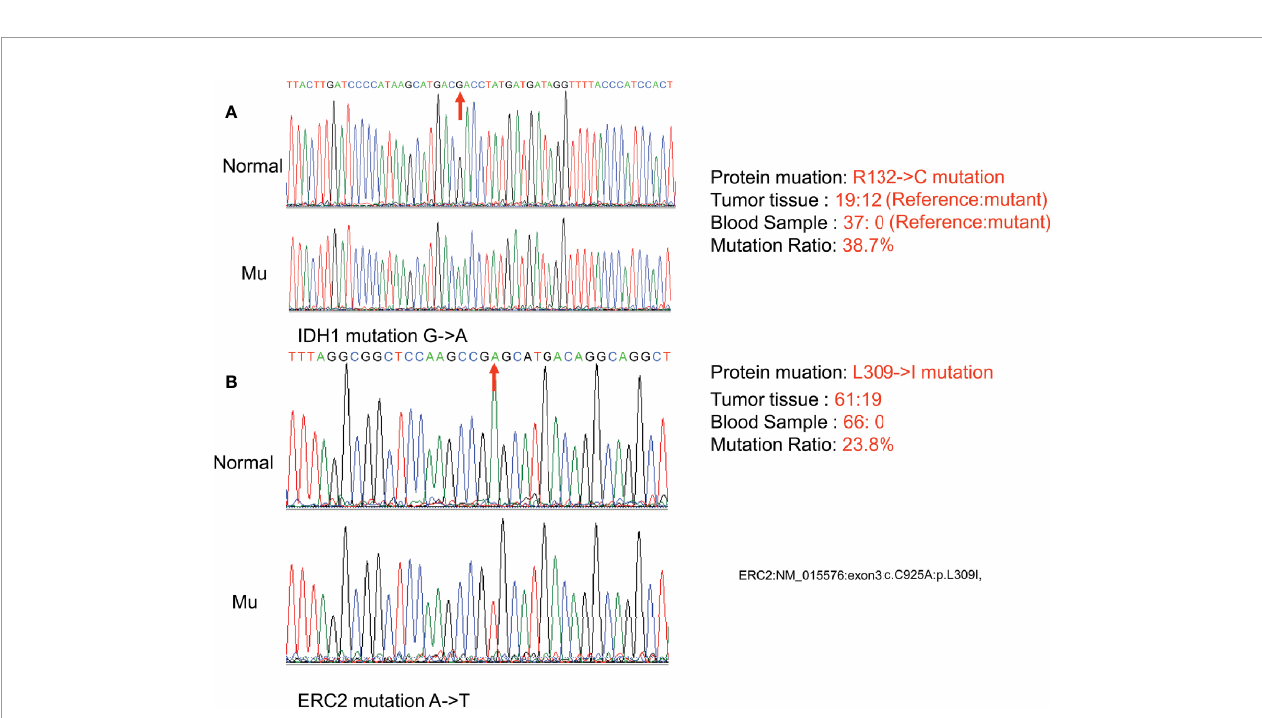
FIGURE 3 | Con fi rmation of somatic nonsynonymous mutation of IDH1 (c. C394T) (A) and ERC2 (c. C925A) (B) by sequencing PCR clones. The fragment fl anking the mutated nucleotide was ampli fi ed by PCR and then cloned into a pMD18-T vector. Twenty-one clones were randomly sequenced to con fi rm the mutations and their frequency. (Normal:Normal;